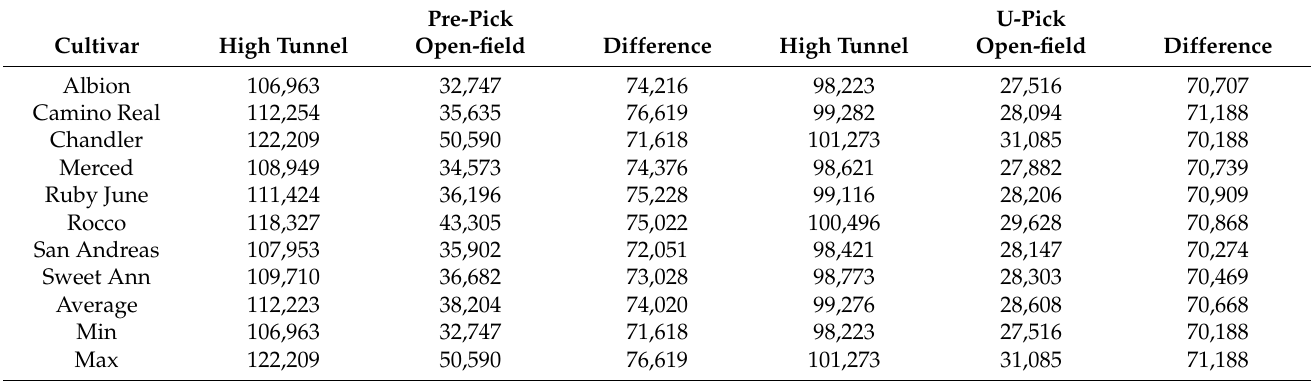
Table A2. Strawberry production costs in USD per hectare (including administrative cost) by cultivar and marketing strategy in the high tunnel and open-field environment.